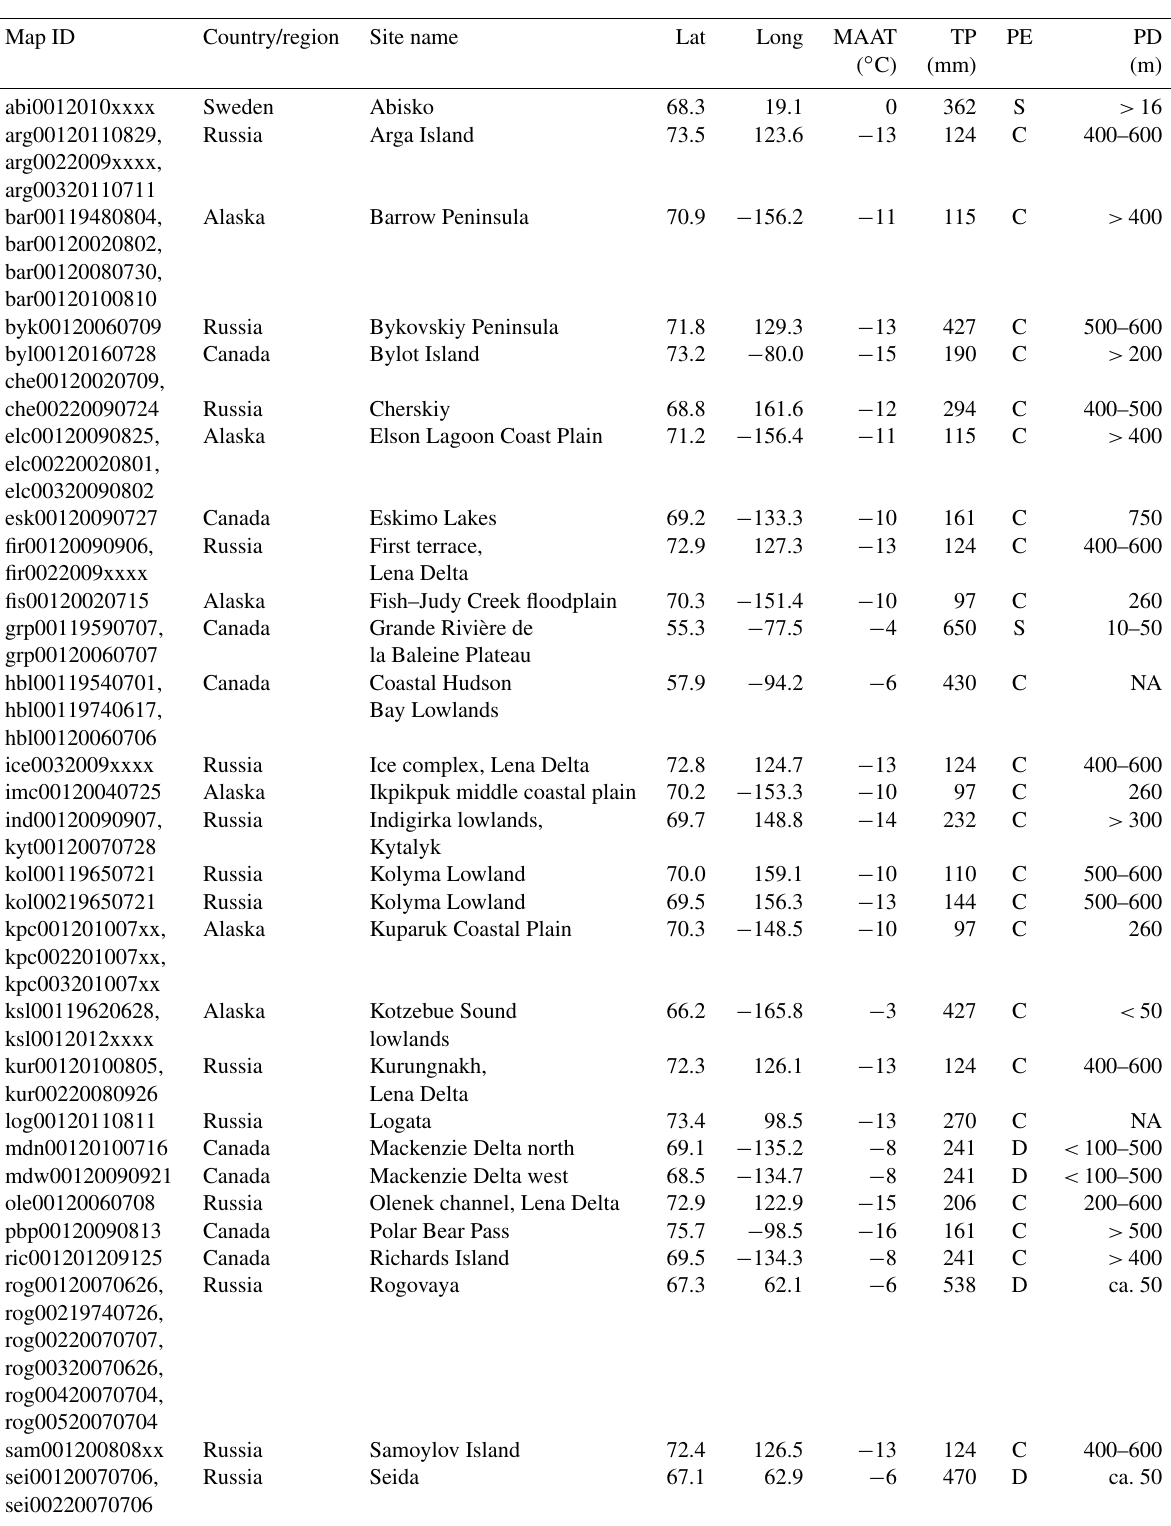
Table 2. Climate and permafrost characteristics for each study area. Latitude (lat) and longitude (long) coordinates are reported in decimal degrees (WGS84). MAAT: mean annual air temperature; TP: total precipitation; PE: permafrost extent (C – continuous, D – discontinuous, S – sporadic); PD: permafrost depth. References to all data sources are listed in Table